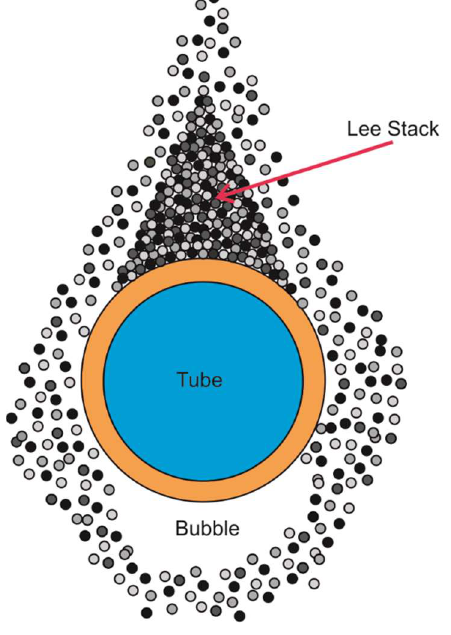
Figure 1. Bed particles packing around a horizontal smooth tube.